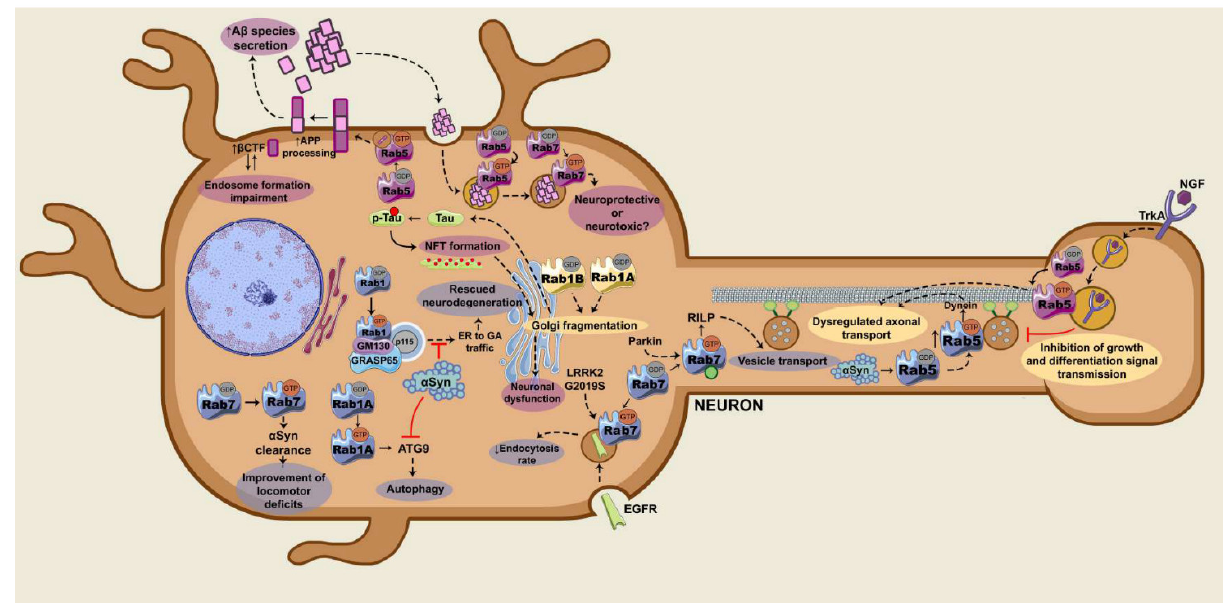
Figure 2. Scheme of the signalling pathways controlled by the small guanosine triphosphatases (GTPases) of the Rab family that are dysregulated in Alzheimer’s disease (AD) (purple), in Parkinson’s disease (PD) (blue) or in both (yellow). Silencing Rab1 induces Golgi fragmentation, while Rab1 overexpression can rescue it in both diseases. Rab1-regulated ER to GA traffic is inhibited by α-syn in PD. α-syn also alters Rab1A/Atg9 axis and consequently reduces the autophagosome formation. Regarding Rab5, its overactivation could alter the axonal transport of growth signals in AD. In PD, α-synuclein (α-syn) overexpression results in an activation of Rab5, which in turn interacts with dynein and dysregulates the axonal transport. Rab5 also participates in amyloid precursor protein (APP) processing, as well as in amyloid-β (Aβ) clearance in coordination with Rab7. This Aβ internalization by Rab5/Rab7 is considered as neuroprotective according to some studies, whereas it is considered as neurotoxic according to others. Rab7 favors the clearance of α-syn aggregates. LRRK2G2019S alters the endocytosis rate, which can be reverted by constitutively active Rab7 overexpression. Parkin ubiquitinates Rab7 and regulates vesicle transport via the Rab7/ Rab-interacting lysosomal protein (RILP) axis. βCTF: β-cleavage C-terminal fragments; ER: endoplasmic reticulum; GA: Golgi apparatus; NFT: neurofibrillary tangle; NGF: nerve growth factor.